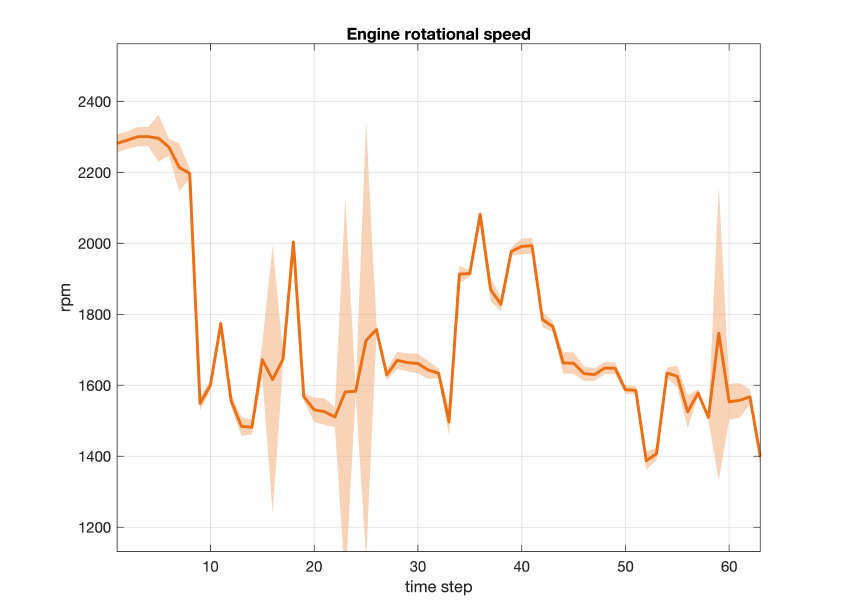
Figure 6. Engine rotational speed (label 1). Average value (continued bold line) and 3-sigma area plot for 203